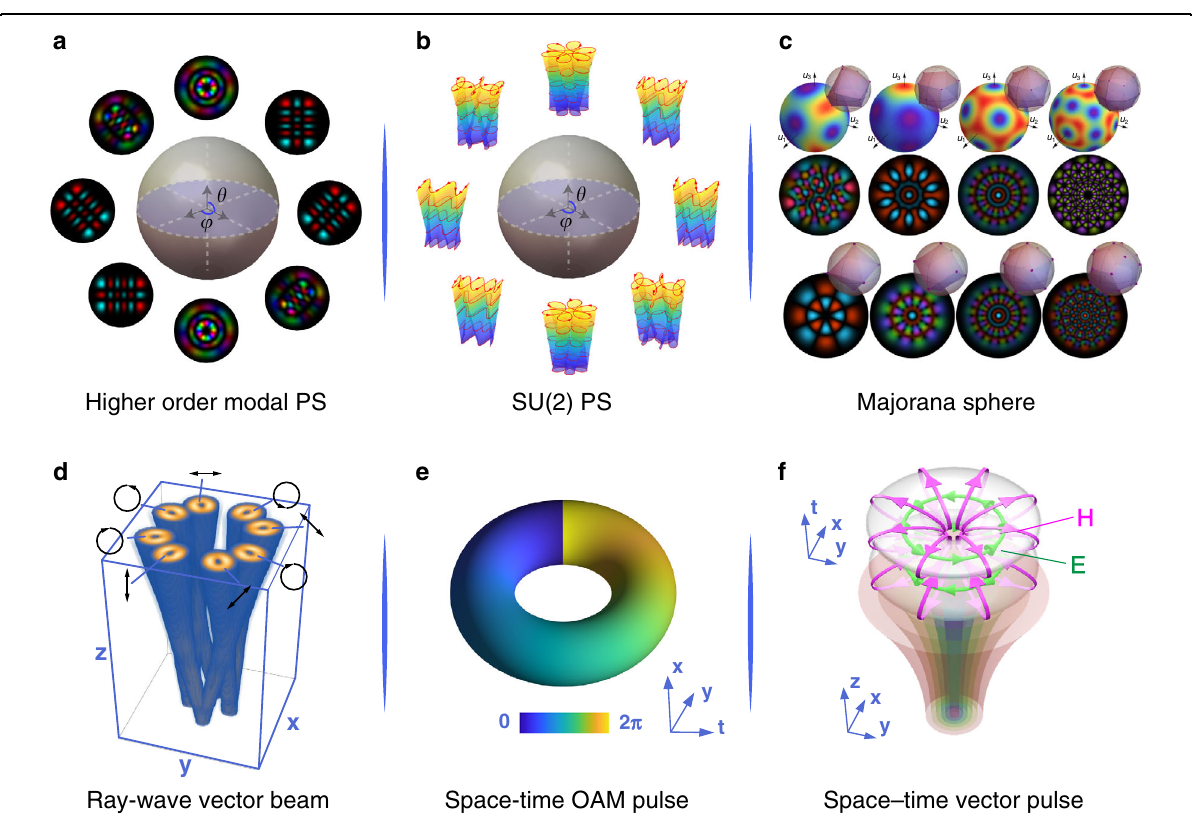
Fig. 2 Structured light towards multiple DoFs and higher dimensions. a High-order PS representation of two-DoF 2D vector beams. b SU(2) PS representation of complex ray-wave geometric modes. c The Majorana sphere exploits hidden dimensions to extend complex structured Gaussian modes. Adapted from ref. 18 . d Spatial vector beams with spatially dependent polarisation pattern. e Spatio-temporal vortex pulses with transverse OAM at space-time. f Flying electromagnetic toroidal pulses as space-time-polarisation non-separable